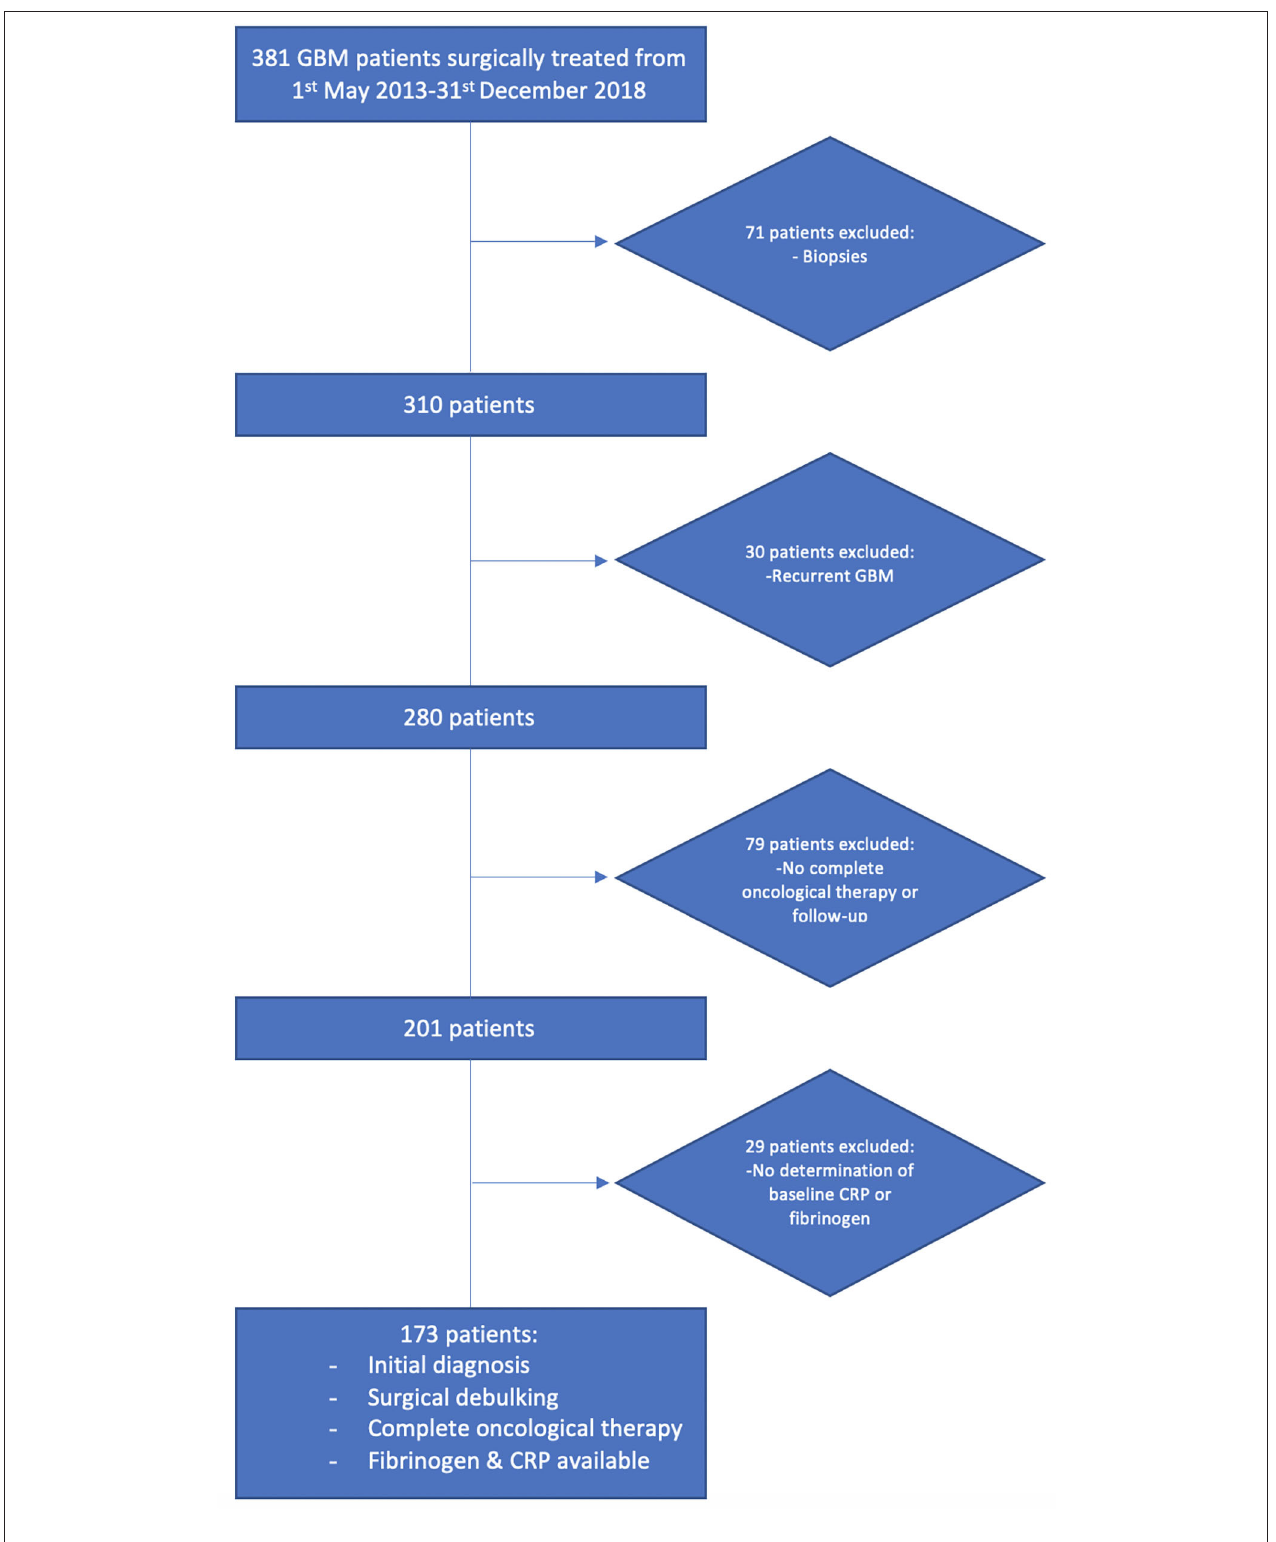
FIGURE 1 | Flow chart illustrating the selection process of consecutive GBM patients between 2013 and 2018.